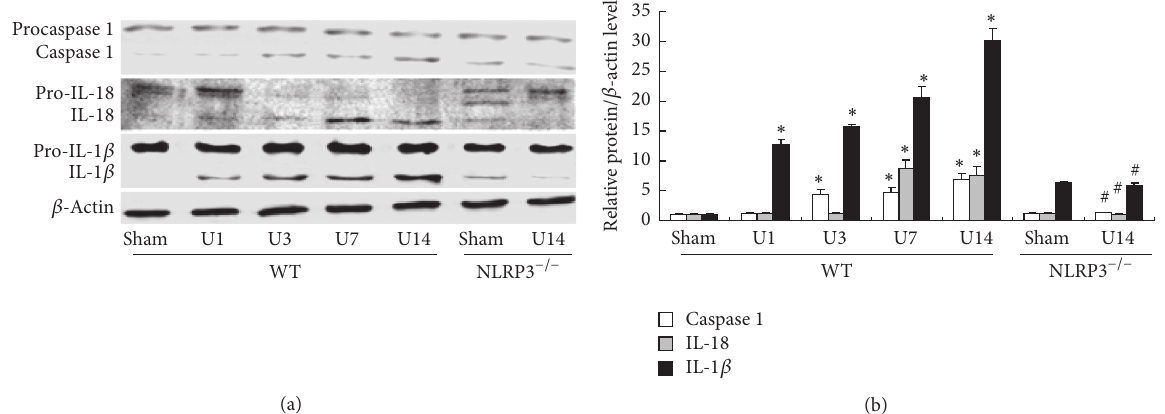
Figure 6: NLRP3 deletion decreases UUO-upregulated expression of NLRP3 inflammasome-regulated cytokines. Expression of caspase 1, IL-1 𝛽 , and IL-18 in kidney samples was detected (a). Semiquantitative analysis of caspase 1, IL-1 𝛽 , and IL-18 normalized against 𝛽 -actin (b). Data represent the mean ± SEM ( 𝑛 = 6 ). ∗ 𝑃 < 0.05 , compared with WT/Sham group, # 𝑃 < 0.05 , NLRP3 −/− /U14 group versus WT/U14 group. U1, U3, U7, and U14 indicate that mice were sacrificed on days 1, 3, 7, and 14 after UUO. WT/Sham